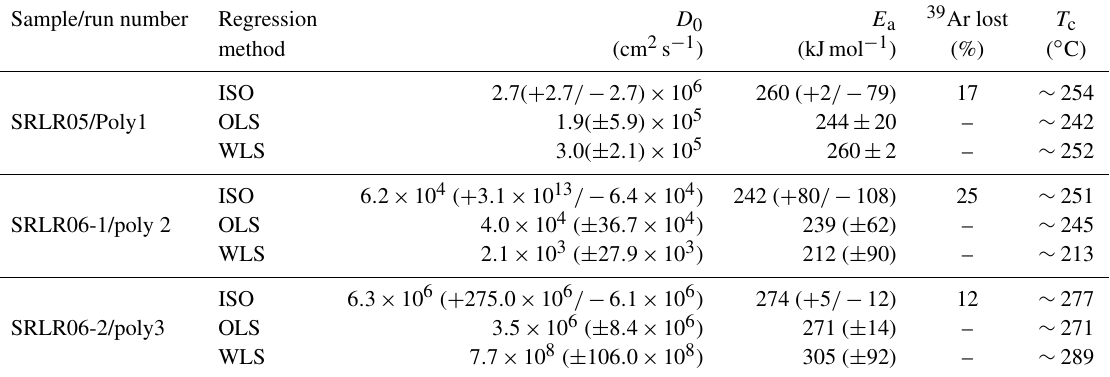
Table 2. Results of step-heating diffusion experiments. Regression acronyms ISO: robust regression in Isoplot V3.7 (Ludwig, 2003), OLS: non-weighted ordinary least square, WLS: weighted (error in ln( D/a 2 )) least